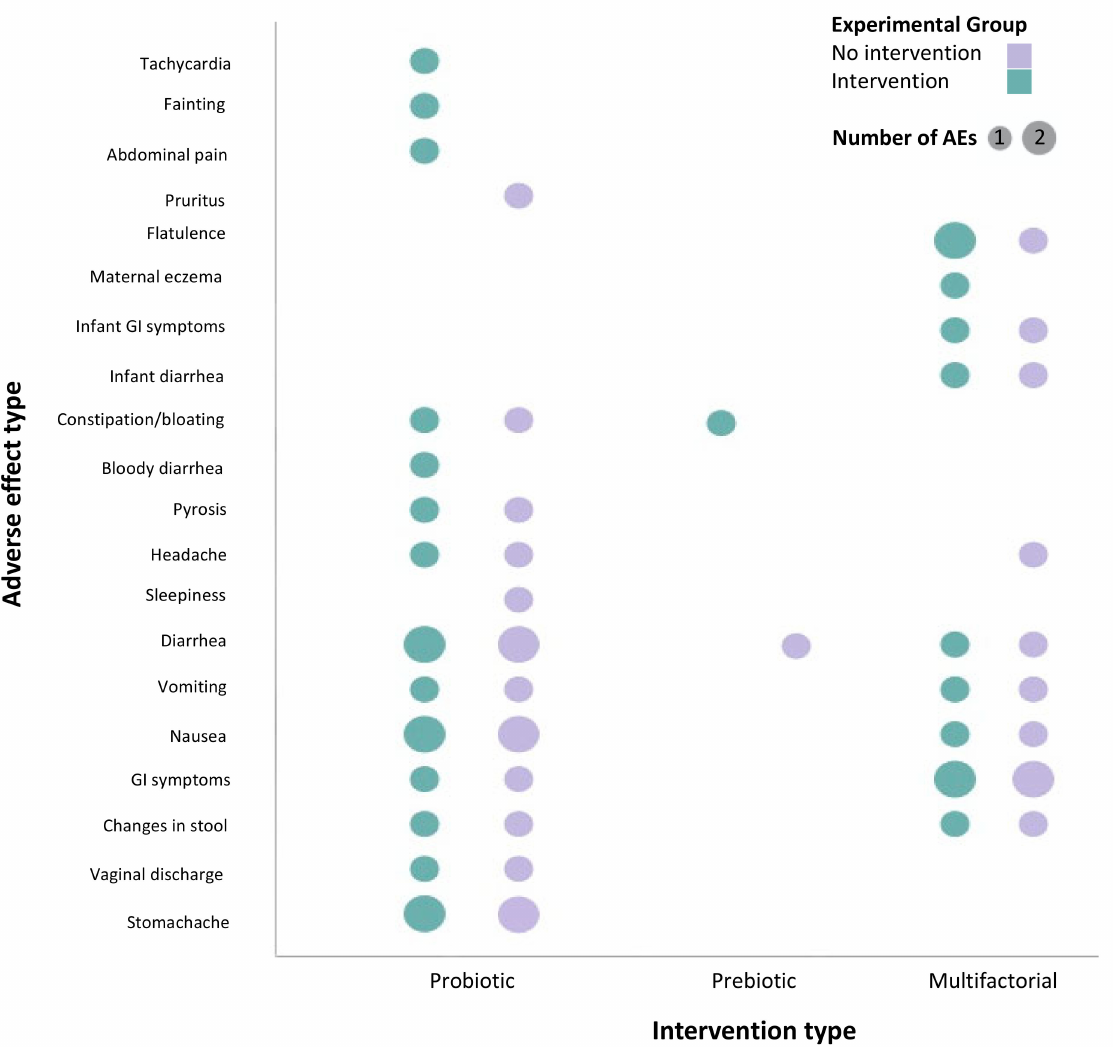
Figure 3. Bubble plot of the type and number of adverse effects stratified by intervention type. The size of the bubble represents the number of times the given adverse effect was reported for the corresponding intervention across all